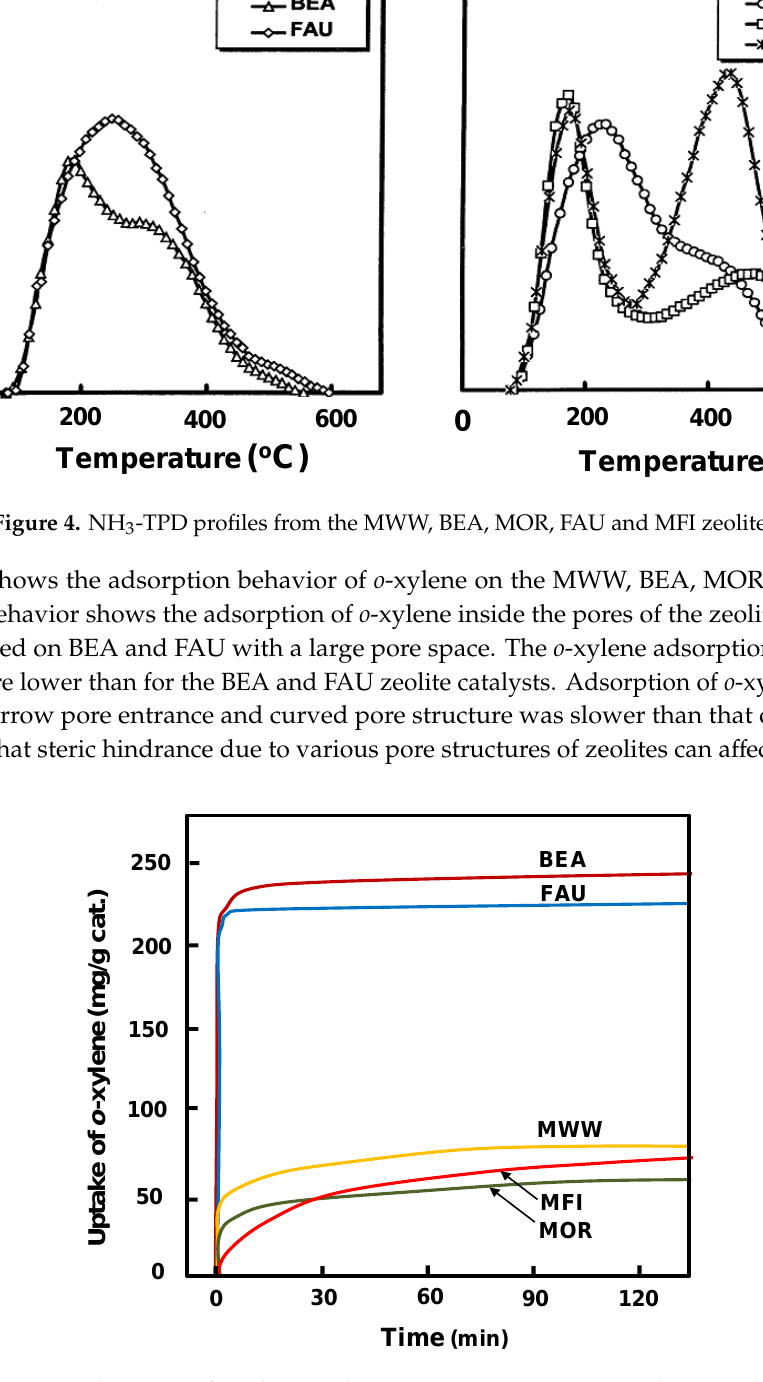
Figure 5. Adsorption of o- xylene on the MWW, BEA, MOR, FAU, and MFI zeolites.